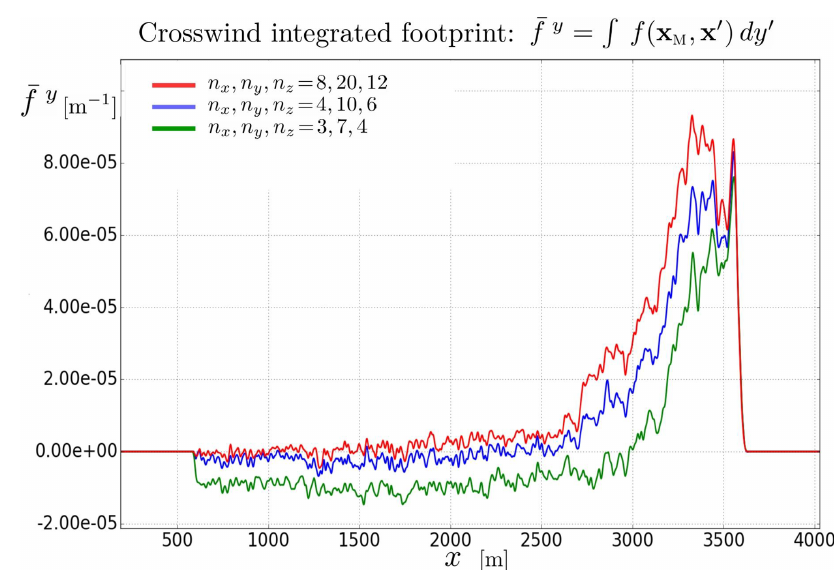
Figure 5. Crosswind integrated distributions of piecewise postprocessed footprints obtained with different levels of target volume discretiza- tions using (cid:104) ¯ w (cid:105) i,j,k from LES solution. Anomalous contributions from subvolumes immediately behind or in contact with the tower structure were omitted from the assembly (refer to Sect.